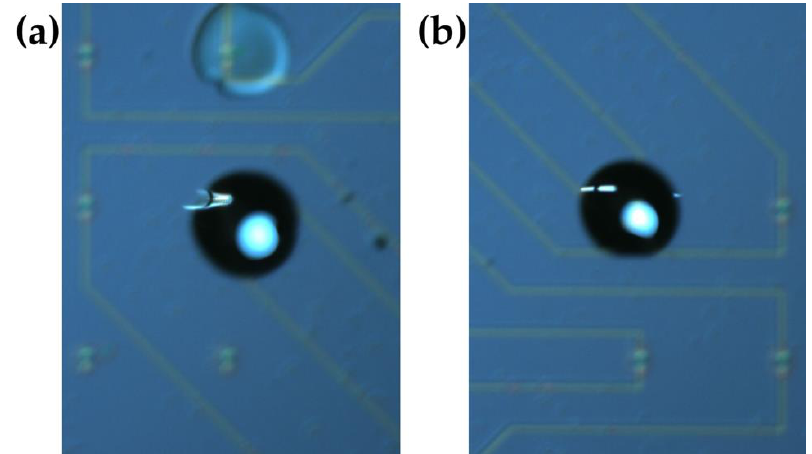
Figure 2. Optical images of the microdrops of aptamer solutions, dispensed onto the surface of individual 3-µm-wide NRs No. 1, No. 4 ( a ), and No. 6 ( b ). The images were obtained via the built-in color CCD camera of the iONE-600 spotter.